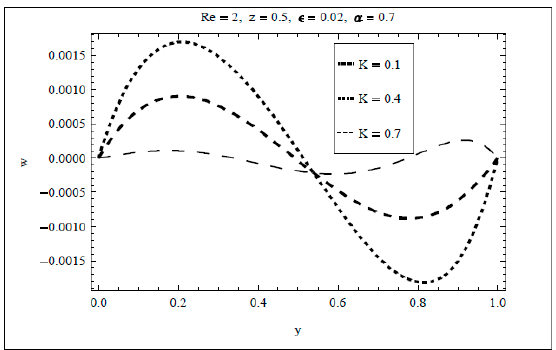
Figure 9. Effect of K on cross-flow velocity w along y .